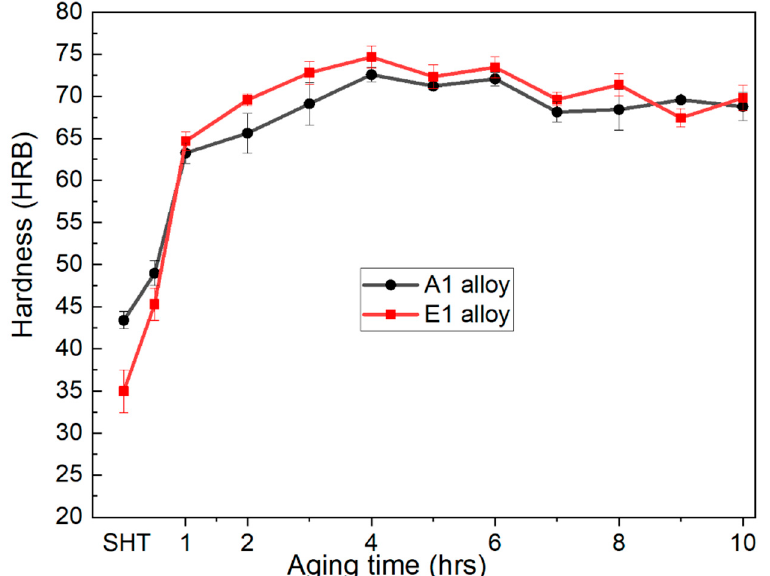
Figure 9. Change in the hardness values with respect to aging time for both examined alloys.